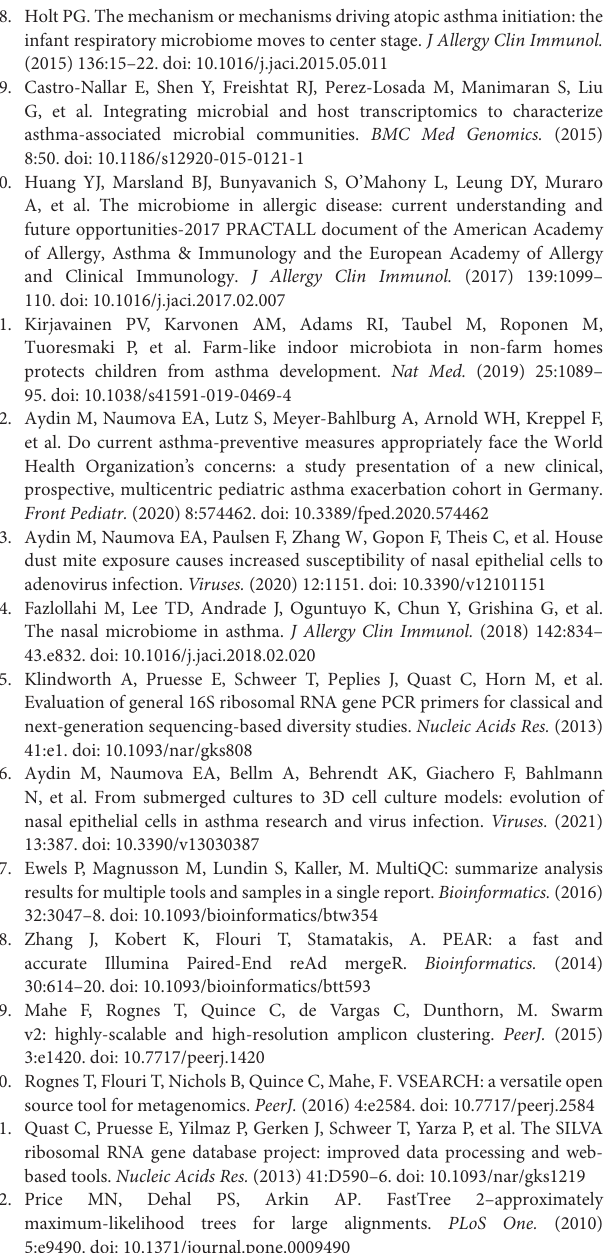
Supplementary Table 1 | Differential abundant taxa and description of significant clusters of the AB, the WH, and the HC. Supplementary Table 2 | Differential abundant taxa and description of significant clusters of the atopic AB, and the WH, in comparison to the